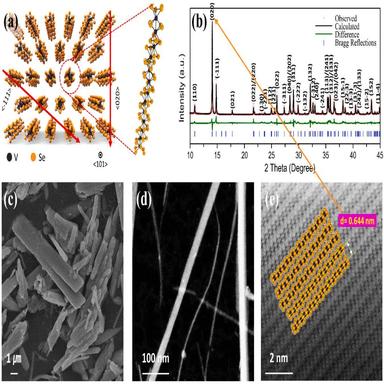
(a) Schematic illustration of the 1D vdW crystal structure of V2Se9. (b) Rietveld refinement of the HRPD patterns of the as-synthesized V2Se9 powder plotted using observed (red-colored circle), calculated (solid line), and difference data. (c) SEM and (d) TEM images of pristine V2Se9. (e) TEM image of the 1D chain structure of pristine V2Se9 with corresponding illustration.